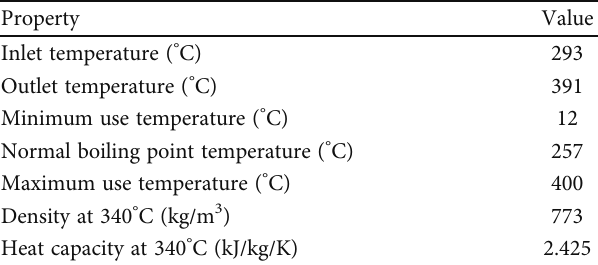
Table 4: Technical speci fi cations for Therminol